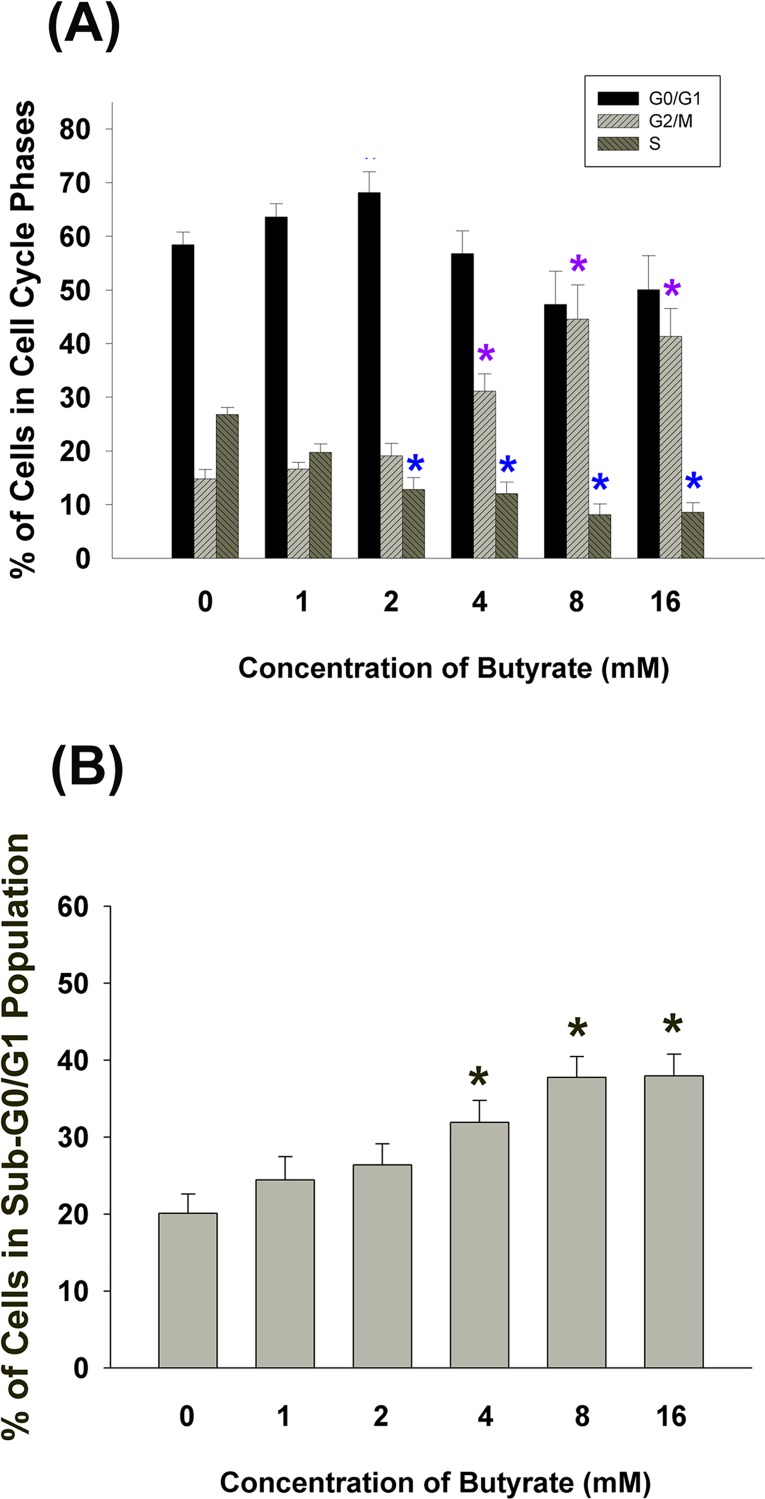
Effect of butyrate on cell cycle distribution of MG-63 cells.(A) The effect of different concentration of butyrate (0–16 mM) on G0/G1, G2/M, and S phase of MG-63 cells (5 x 105 cells/well) after 24 hrs exposure time. *denotes significant difference when compared with control (P < 0.05). (B) The effect of different concentration of butyrate (0–16 mM) on sub G0/G1 population of MG-63 cells (5 x 105 cells/well) after 24 hrs. *denotes significant difference when compared with control (P < 0.05).